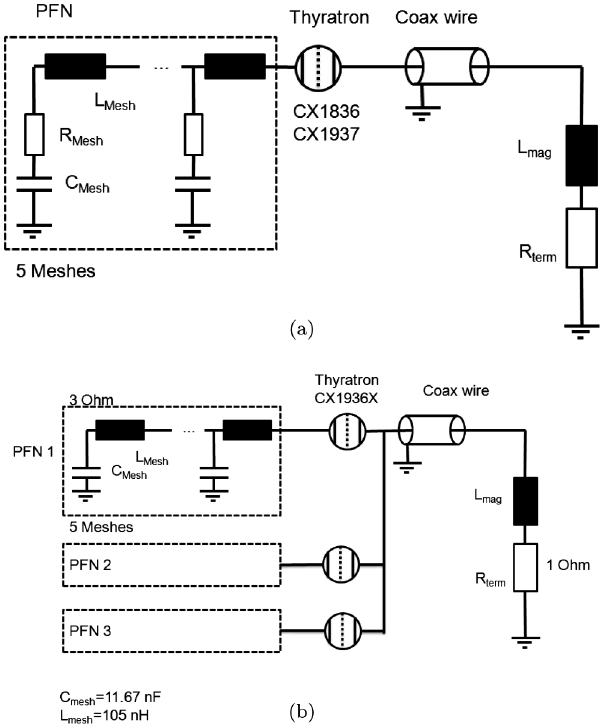
FIG. 37. Schematic of the PFN for (a) protons and (b) carbon.